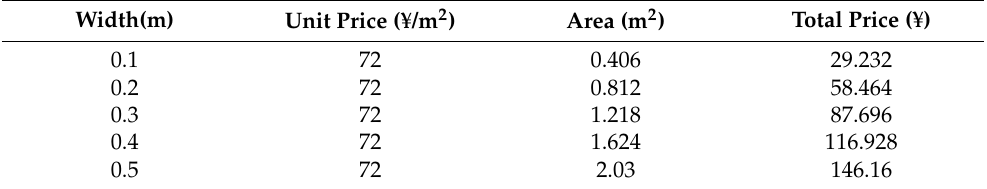
Table 8. Widths and prices of aluminum